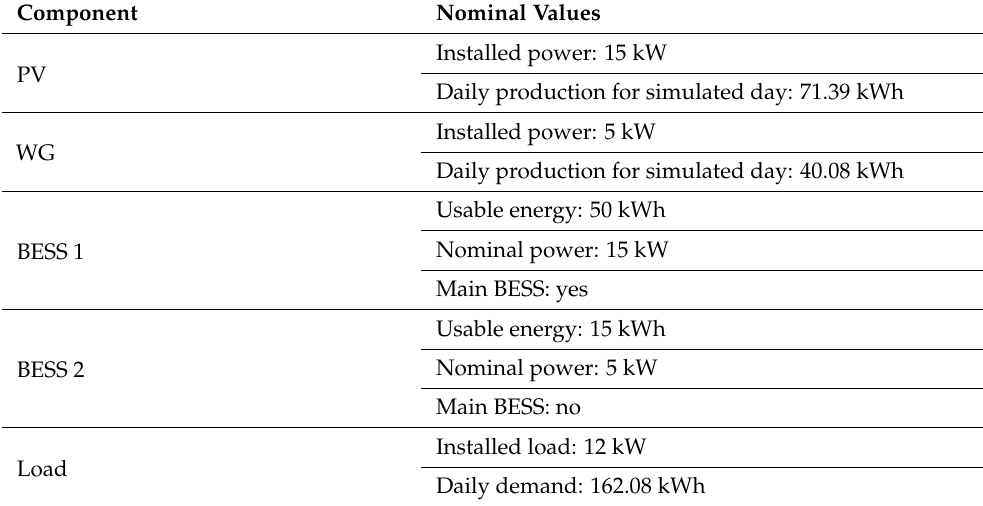
Figure 4. Graphical representation of CIEMAT’s MG. Figure 4 . Graphical representation of CIEMAT’s MG. Table 1. MG Table 1 . MG description.